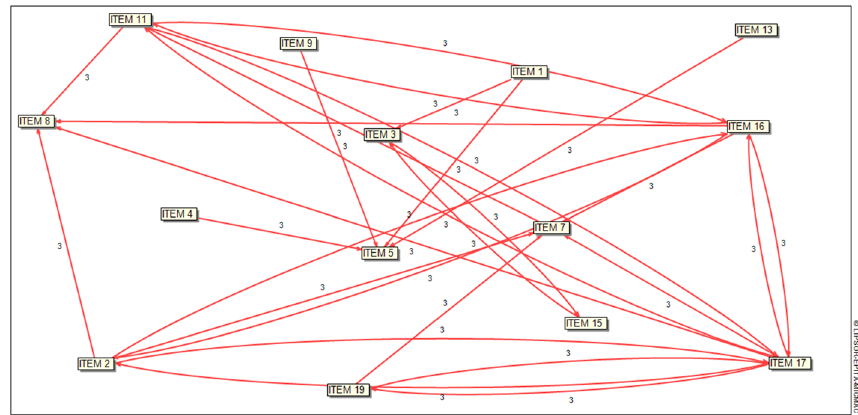
Fig. 2 Graphical representation of strong effects among variables of the